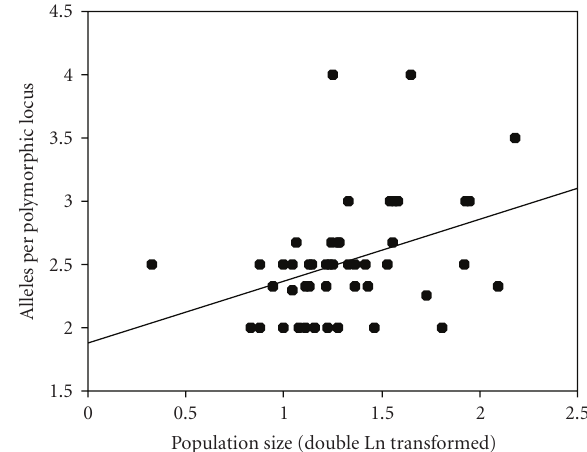
Figure 5: Alleles per polymorphic locus as a function of the population size (double natural log transformed), for Nolina brittoniana . r = 0.376, P = .